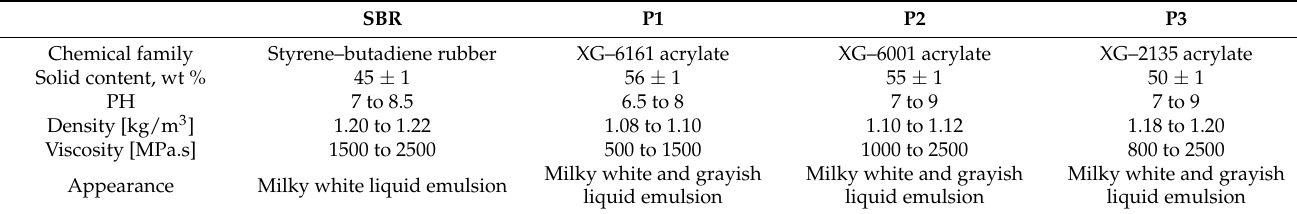
Table 2. Polymer latex characteristics.